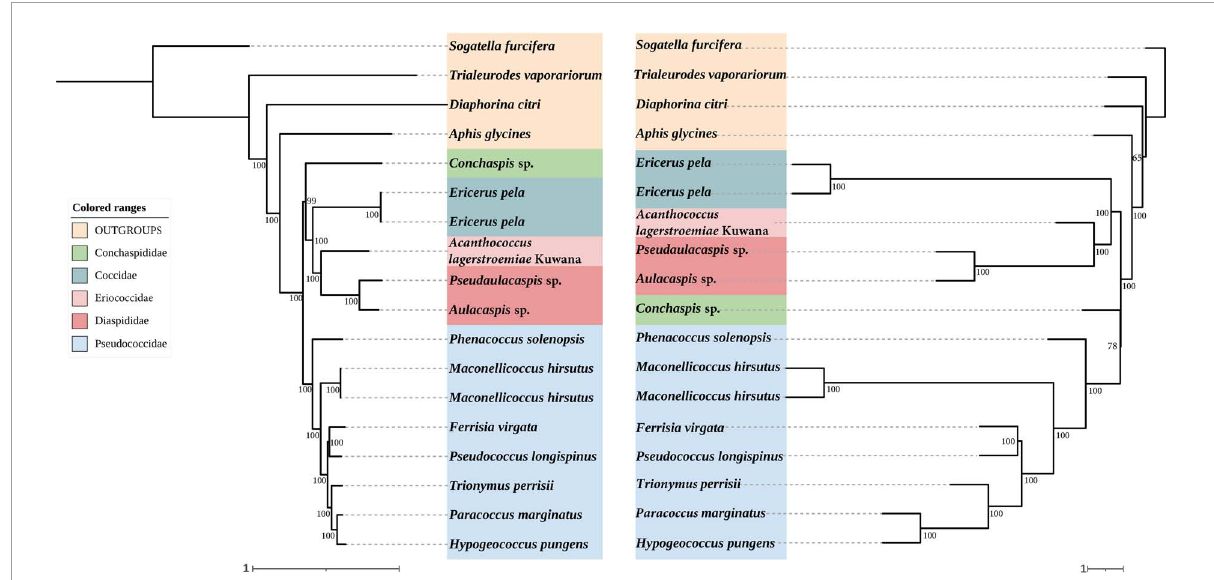
FIGURE2 Left: Concatenated tree of 75% completeness matrices from Coccoidea probe set. Node values are bootstrap support. Right: Species tree of 75% completeness matrices from Coccoidea probe set. Node values are bootstrap support.